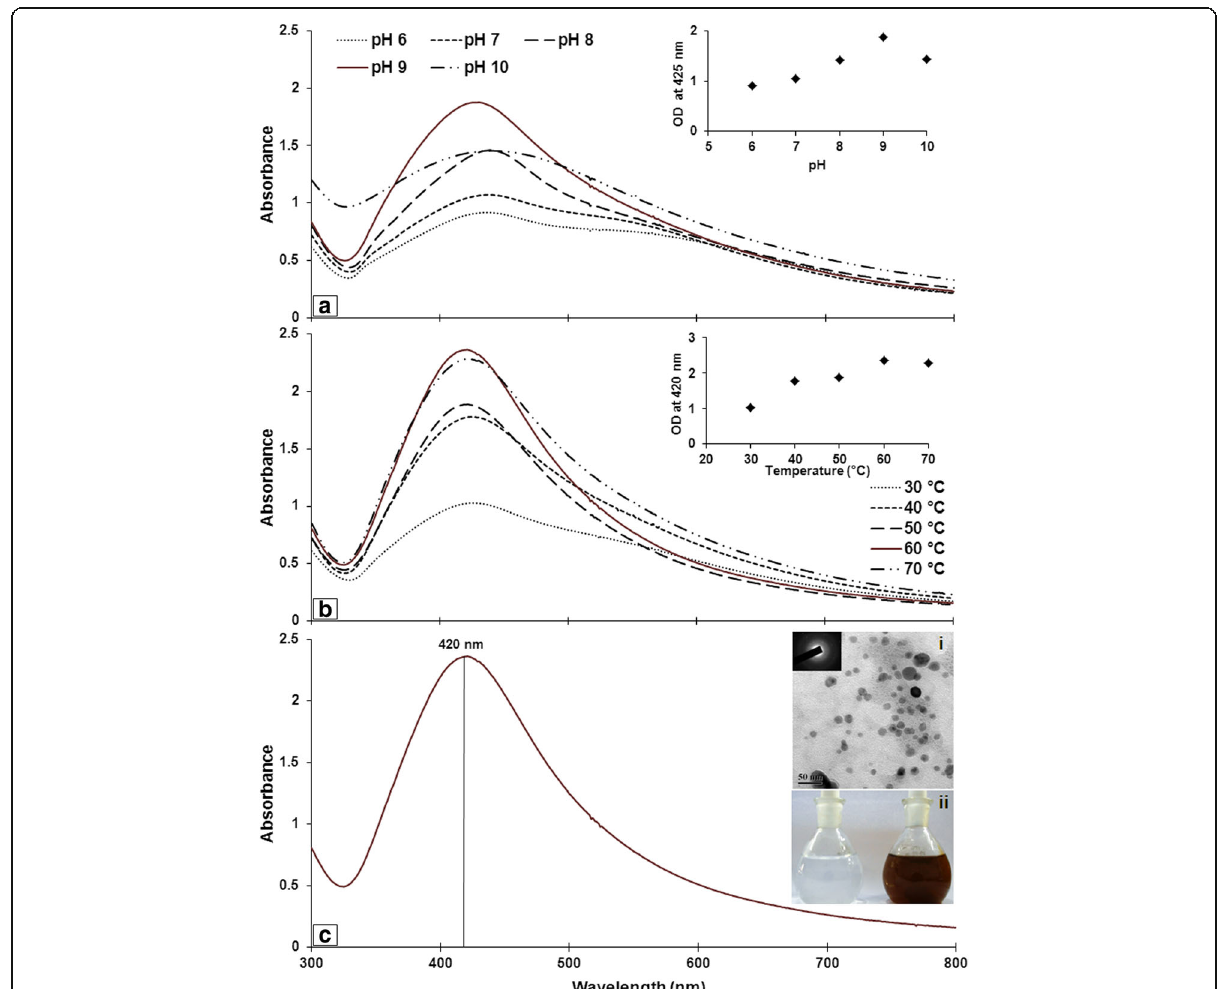
Fig. 1 UV-vis spectra of Piper betle mediated silver nanoparticles recorded after overnight incubation at room temperature: a After being treated at different pH (pH − 6, pH − 7, pH − 8, pH − 9, and pH − 10). b After being treated at different temperatures (30 °C, 40 °C, 50 °C, 60 °C, and 70 °C). c UV-vis spectra of Piper betle mediated silver nanoparticles (incubate: 60 °C; pH 9) showing maximum absorbance at 420 nm. c (i) Transmission electron micrograph (TEM) image of synthesized silver nanoparticles. The SAED pattern of PbSNPs is presented in the inset. c (ii) Represent color change detected in the reaction mixture containing ethanolic extract of Piper betle leaf and 1 mM silver nitrate